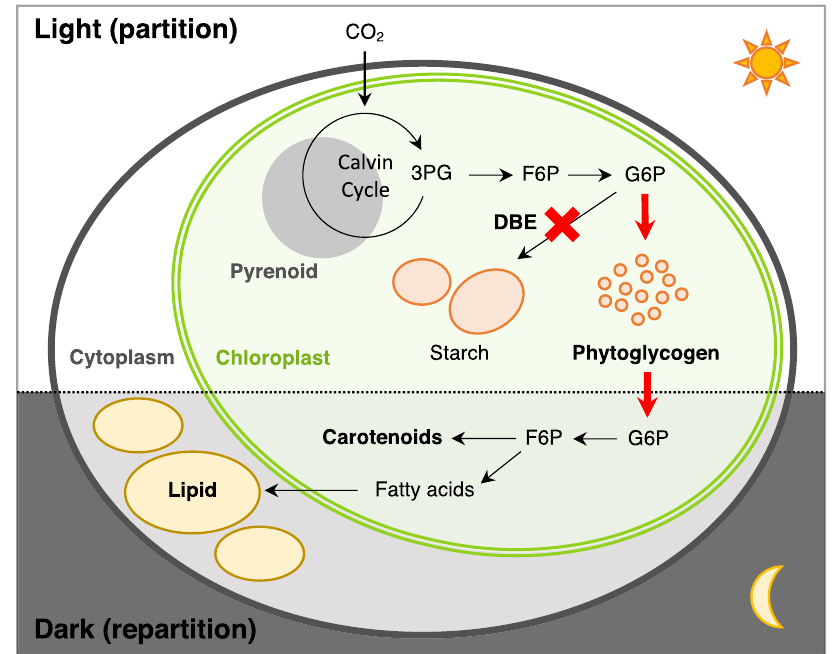
Fig. 7 Carbon partition/repartition model for DBE-de fi cient microalgae under light/dark conditions. DBE-de fi cient microalgae accumulate carbohydrate as phytoglycogen, instead of starch. Under light conditions, carbon resources derived from CO 2 are partitioned into phytoglycogen. Under dark conditions, phytoglycogen is rapidly converted into intermediate metabolites and then repartitioned into lipid/carotenoid.